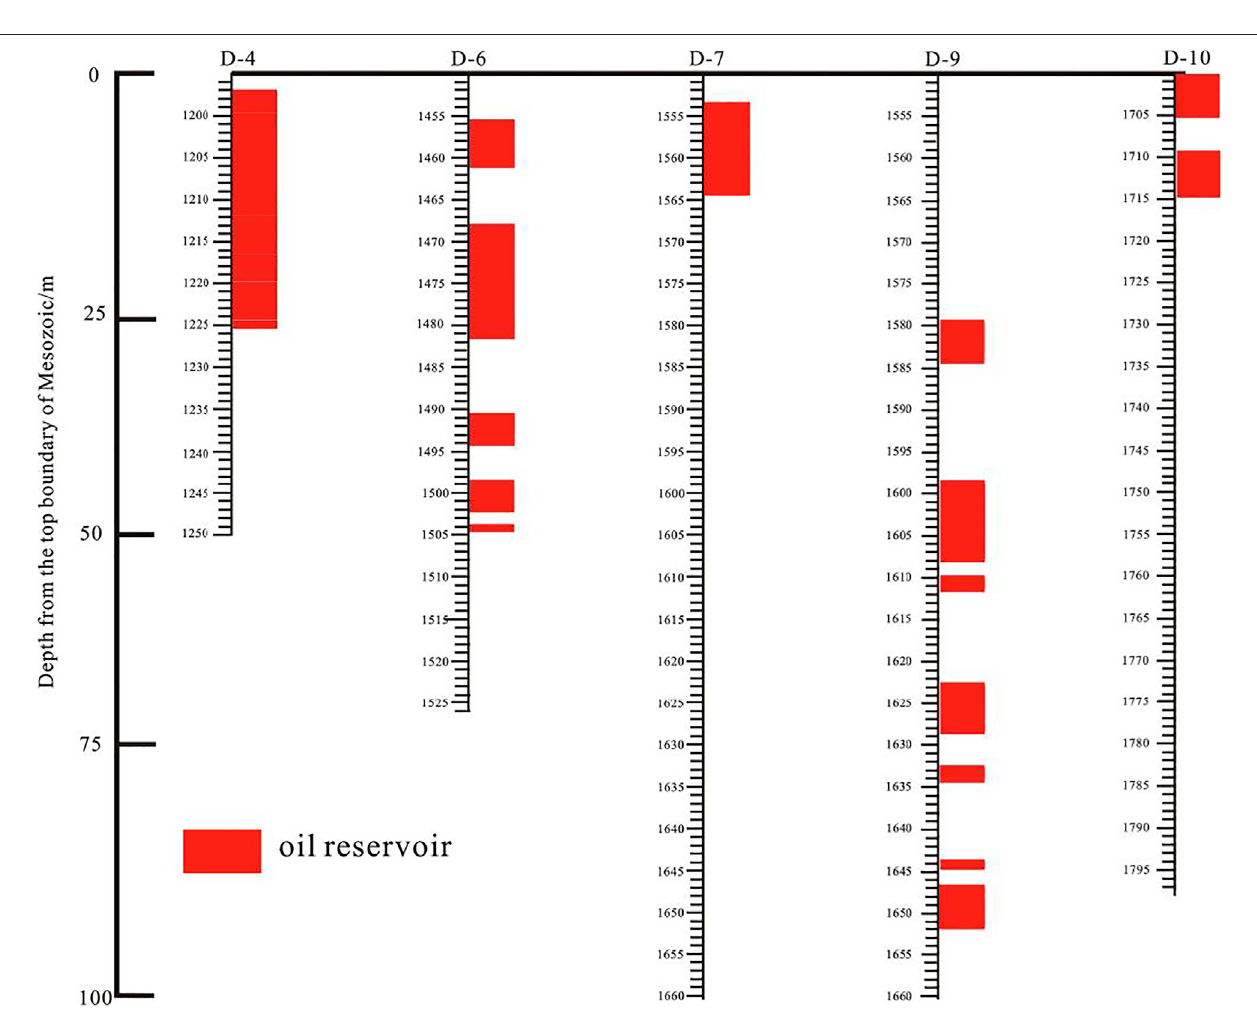
FIGURE 16 | The distance between the oil bearing section of oil wells and the top boundary of the Mesozoic in the study area.